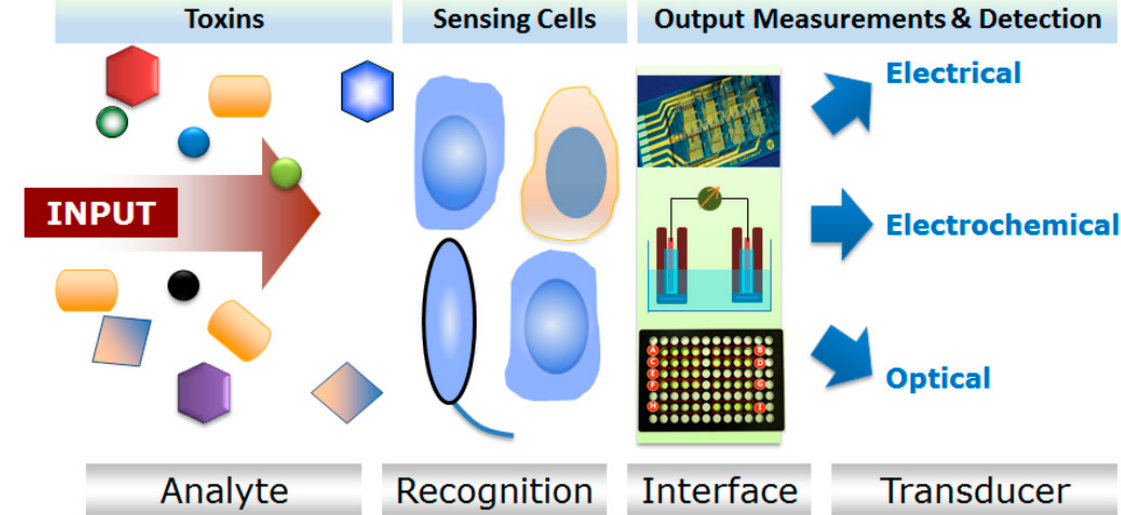
Figure 2. A generalized working principle of cellular sensors. Reproduced from Banerjee et al. [28], an open-access article distributed under the terms and conditions of the Creative Commons Attribution license (http://creativecommons.org/licenses/by/3.0/).